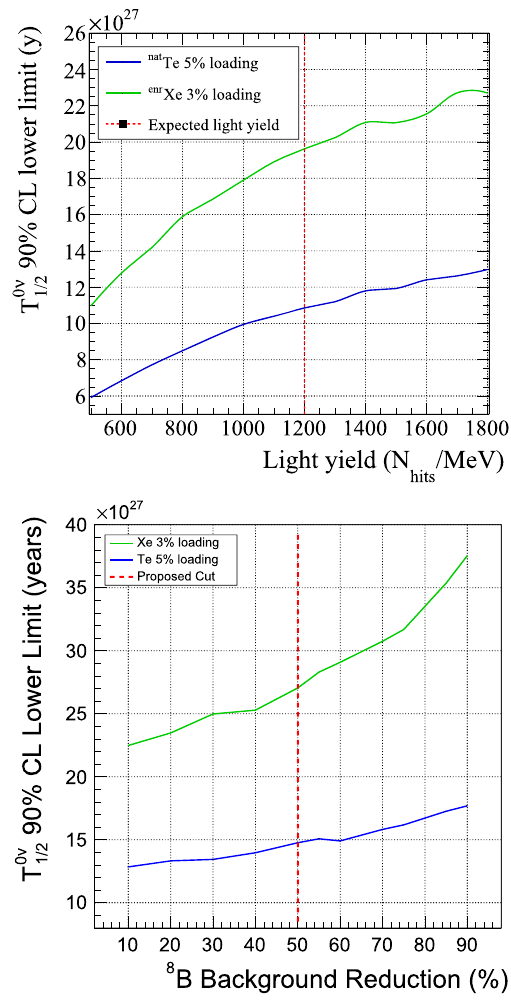
Fig. 17 Half life sensitivity as a function of key experimental parame- ters; (top panel) light yield and (bottom panel) 8 B solar neutrino reduc- tion. The vertical dashed red lines show the values used in the analysis. For the same detector optical properties, a variation in the light yield corresponds to a scaling on the PMT coverage.The plot showing the 8 B reduction as a function of the light yield does not include the signal efficiency of